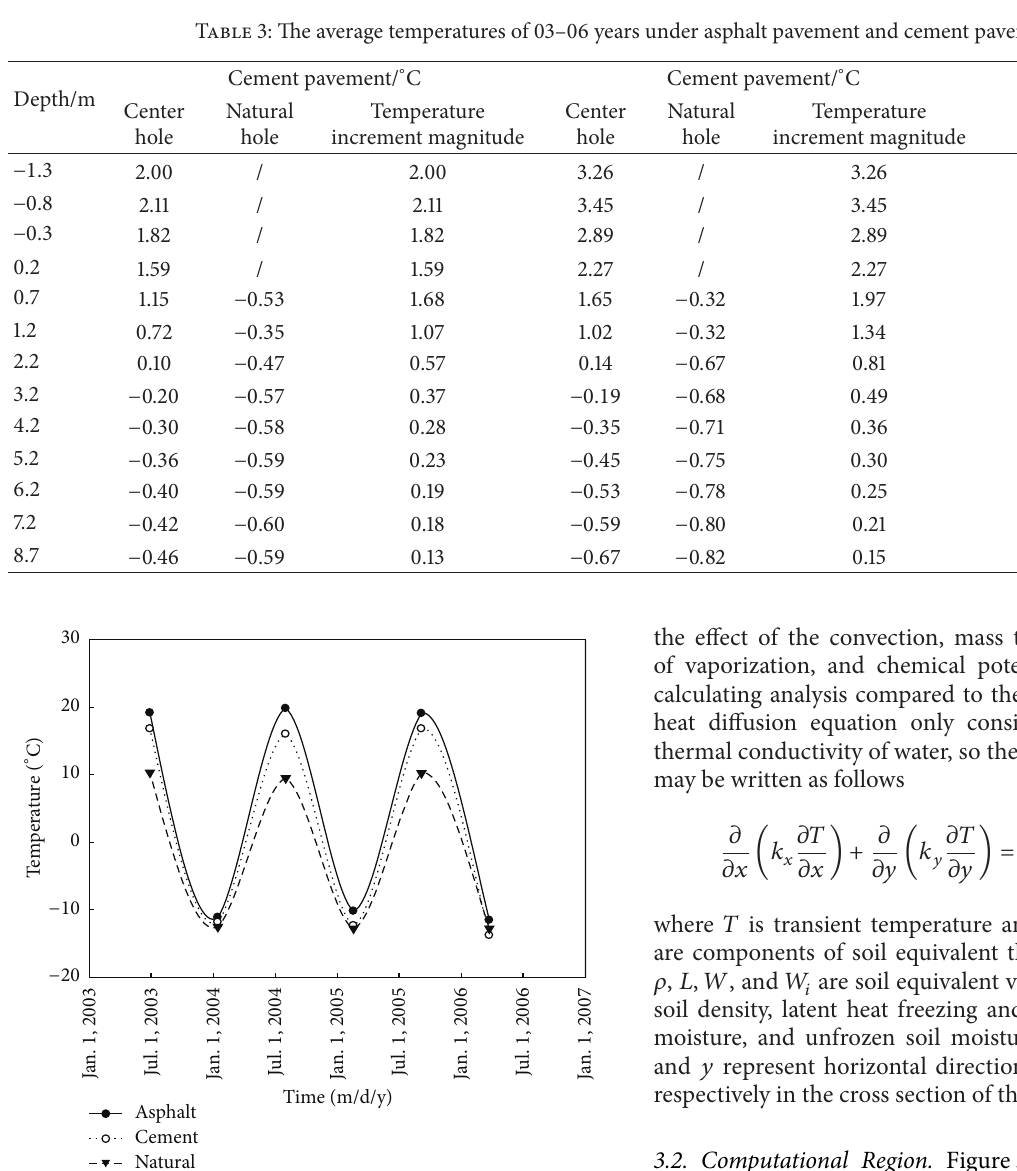
(2) No external load acts on soil layer during freezing